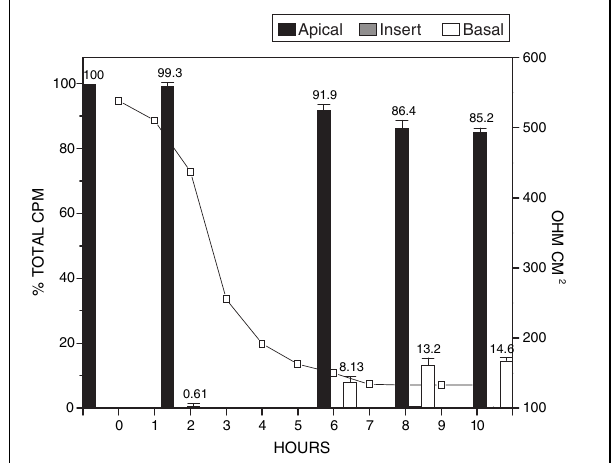
Figure 1) Translocation of 125 I-bovine serum albumen (BSA) in the presence of toxin A and toxin B. Confluent Caco-2 monolayers on transwell inserts were inoculated with 250 µL of both toxin A and toxin B (both toxins at 0.250 µg/mL) and 100 µL 125I-BSA (0.250 µg/mL). Samples from apical, basal and insert were tested for per cent of the total input counts per minute (cpm). The figure represents the average of three separate experiments. The electrical resistance measurements indicate the level of tight junction integrity. The total amount of radioactivity inoculated onto the insert in the form of radiolabelled BSA was 2.8 × 10 3 cpm